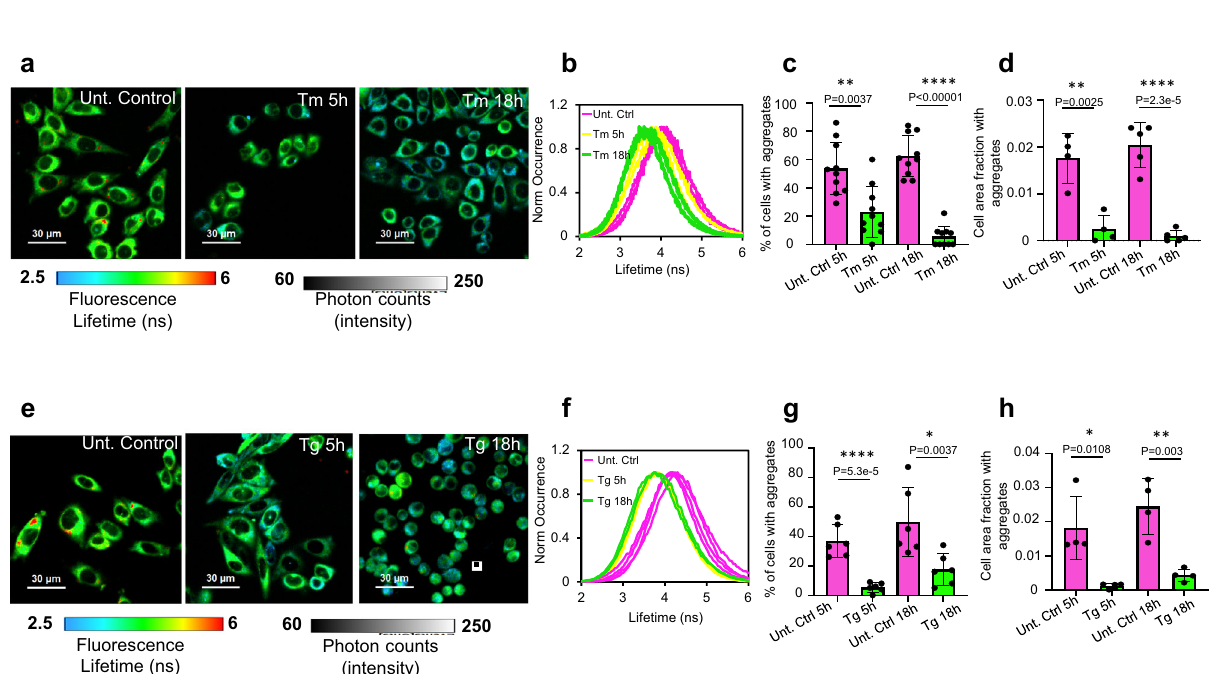
Fig. 3 Pharmacological ER stress induction activates protein disaggregation machinery. a , e FLIM images of live CHO-K1 cells stably expressing HT-aggr ER , untreated or treated with tunicamycin (Tm at 0.5 µ g/mL) or thapsigargin (Tg at 0.5 µ M) for a time period post-pulse-labelling with the P1 fl uorochrome as indicated. b , f Histograms representing frequency distribution of pixel fl uorescence lifetime from image-series as in ( a , e ), note the shift towards shorter lifetime values post-treatment (traces represent individual cells, untreated control, pink; 5 h treatment, yellow; 18 h treatment, green). c , g Quantitation of the relative number of cells with FLIM-detected aggregates in images as in ( a , e ). d , h Plots of relative cell area occupied by FLIM-detected aggregates (lifetime > 5 ns, red puncta) in images as in ( a , e ). Mean ± SEM, n = 10, 5, 6, 4 independent fi elds of view containing at least 12 cells each ( c , d , g , h ), respectively. * P < 0.05; ** P < 0.01; *** P < 0.001; **** P < 0.0001, unpaired T test (two-tailed). Table 1 Turnover of HT ER variants, labelled with following the label removal, the samples were chase-imaged in the absence or presence of an ER stressor, tunicamycin (Tm, 0.5 µ